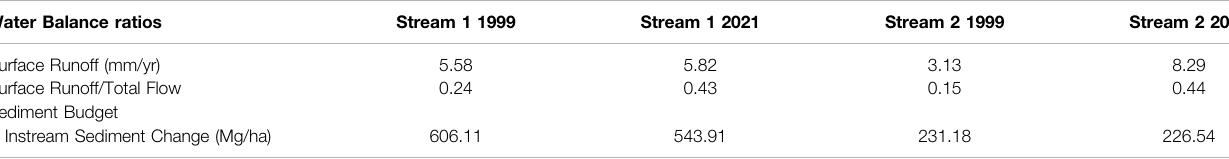
TABLE 8 | SWAT results for Š tavska River selected Southern mountainous